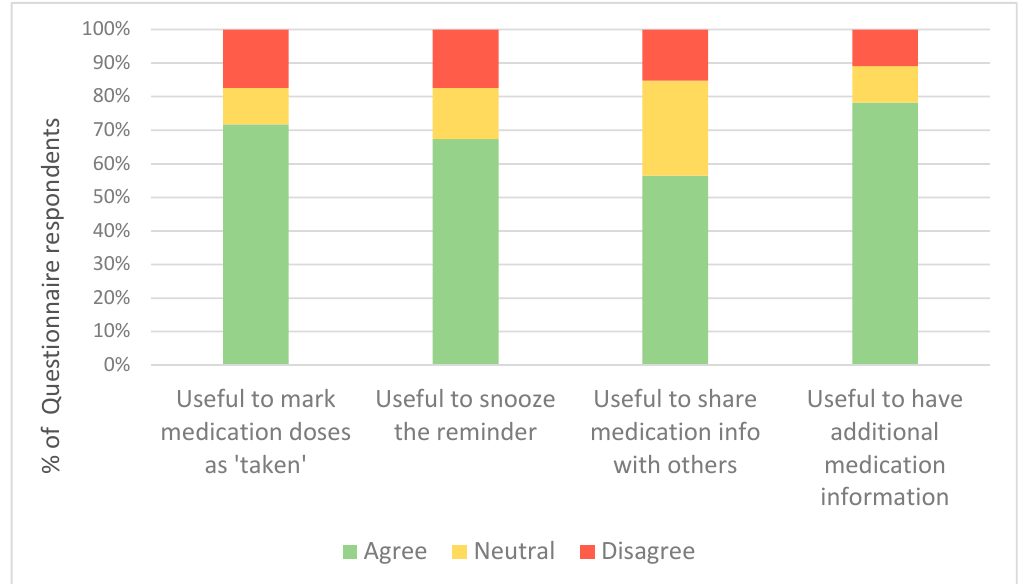
Figure 4. Engagement-related questionnaire responses in both basic and advanced app groups. *1 missing response in the basic medication reminder app group.